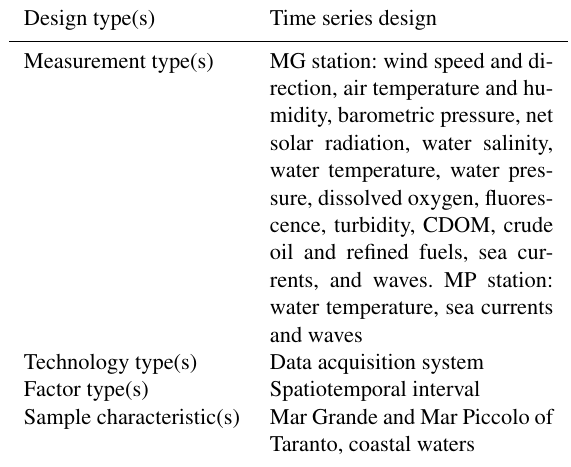
Table 1. Main characteristics of the two monitoring stations MG and MP.